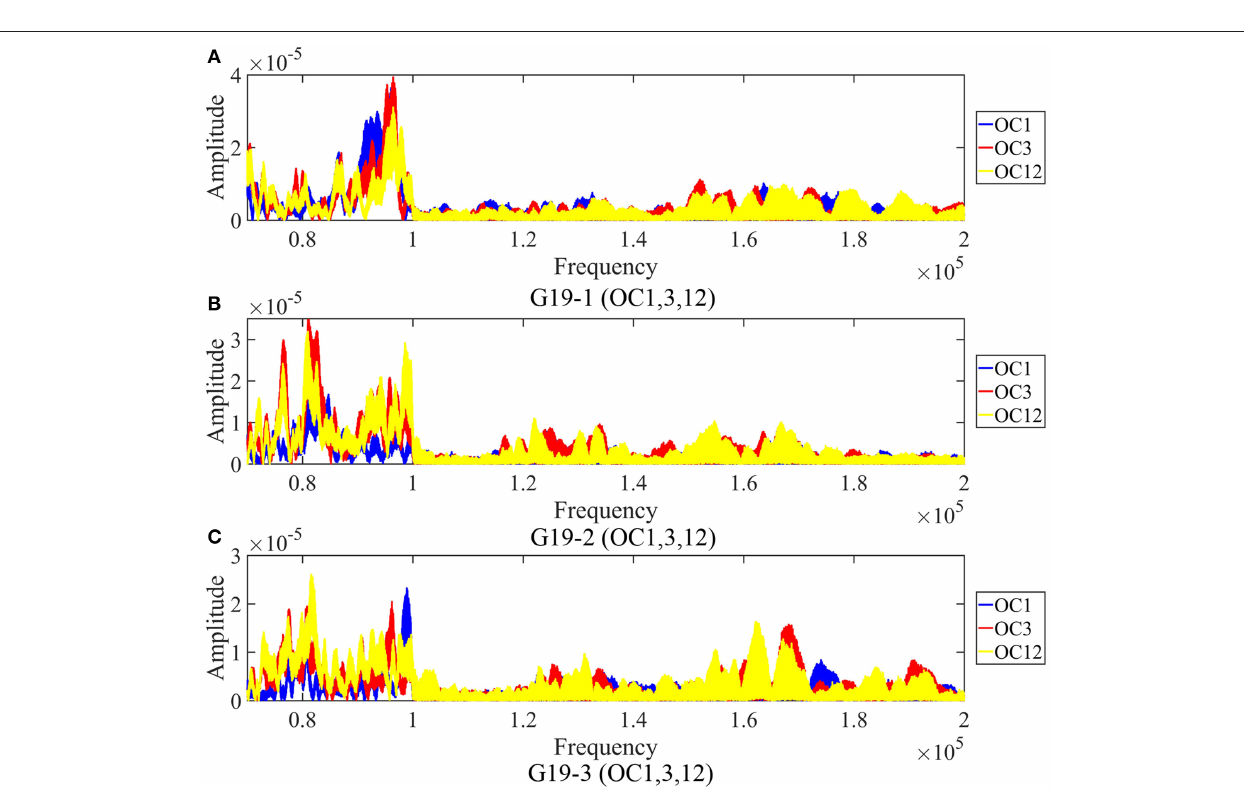
Frontiers in Materials |